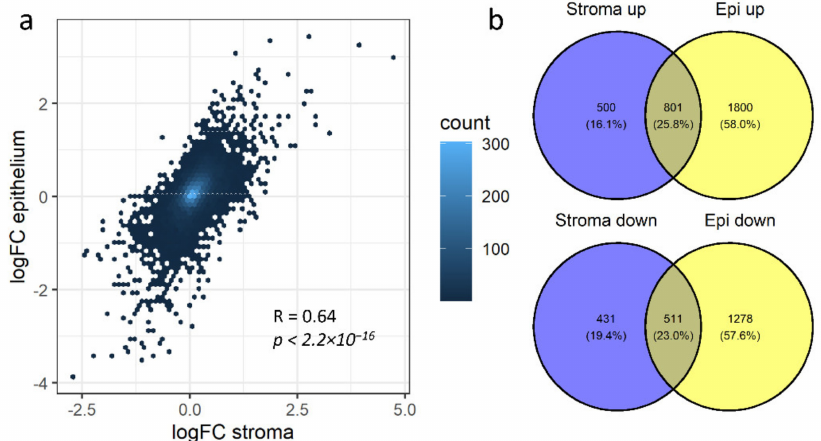
Figure 2. DEGs comparison between stroma and epithelium. ( a ) Cross-datasets average logFC for genes measured in normal/cancerous stroma (X axis) or in normal/cancerous epithelium (Y axis). Pearson’s correlation and p -value are indicated; the colour indicates the number of overlapping dots. ( b ) Venn diagrams comparing significant DEGs ( p -adjusted < 0.05) detected in the stroma and in the